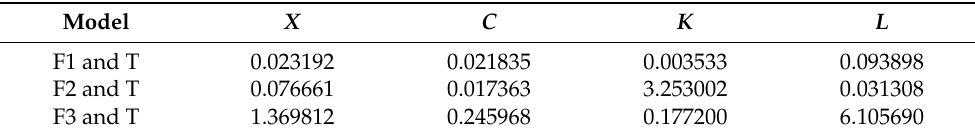
Table 5. Fisher Criterion for F1–F3 and T-Mode Characteristic Variables.